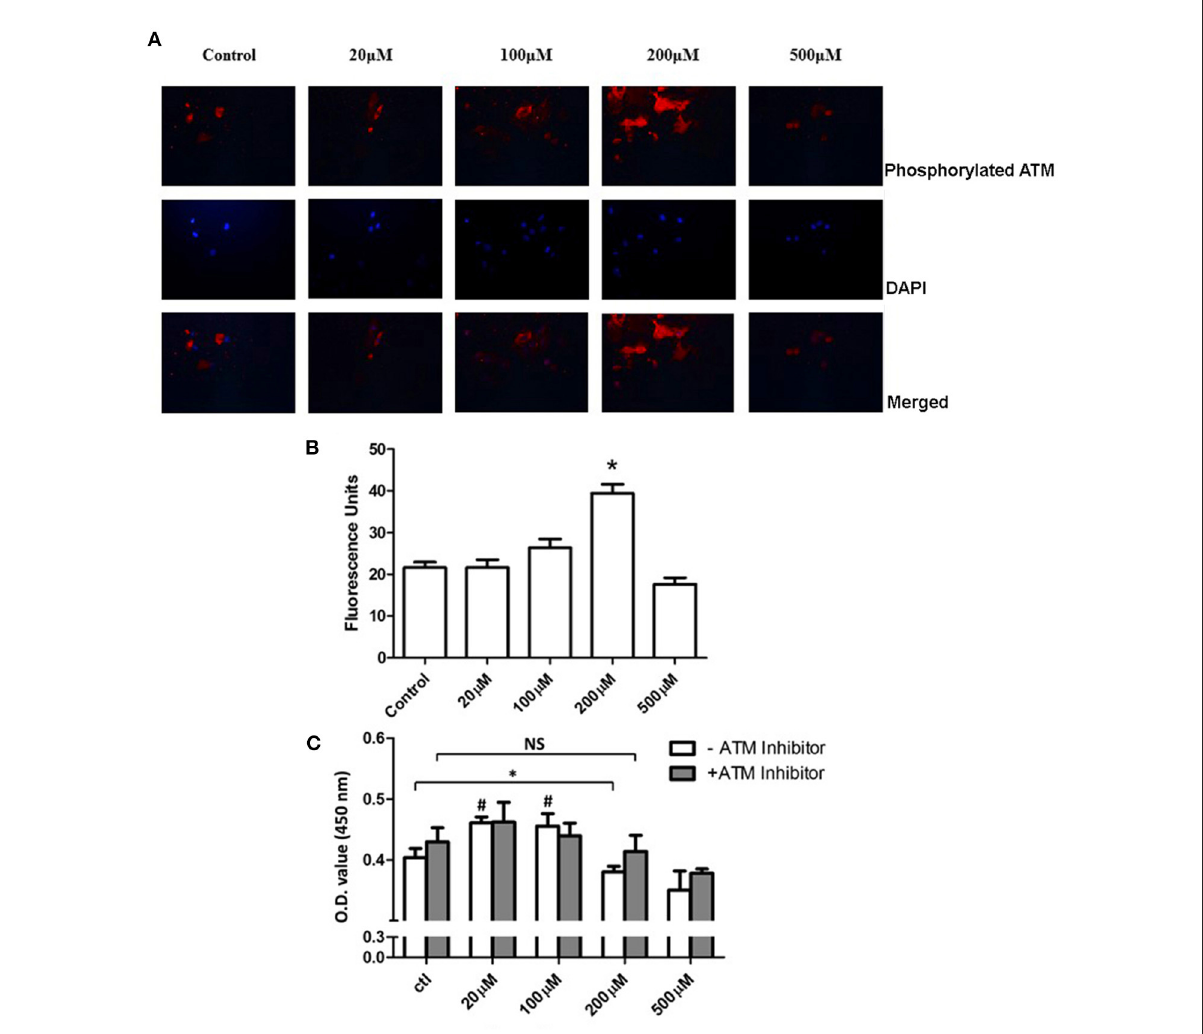
FIGURE6 Inhibition of ATM promotes the proliferation of PASMCs under a high concentration of extracellular H 2 O 2 . (A) Immunohistochemistry staining of ATM under PDGF-BB stimulation was shown in the first panel. Images of DAPI staining for the nucleus were shown in the middle panel. The merged images were represented in the last panel. (B) Quantification data of intensities of images were shown. The intensity of the 200 µ M group showed significantly higher than the control group ( P < 0.05). (C) Cell Counting Kit-8 results showed that the 20 and 100 µ M groups had significantly higher proliferation levels compared to the control group ( P < 0.05). Under 200 µ M of H 2 O 2 stimulation, significantly decreased proliferation was discovered ( P < 0.05). With the pretreatment of ATM inhibitor, no further significant difference was found between 200 µ M of H 2 O 2 and the control group ( P > 0.05). N = 5. # P < 0.05 vs. control. * P < 0.05 vs.